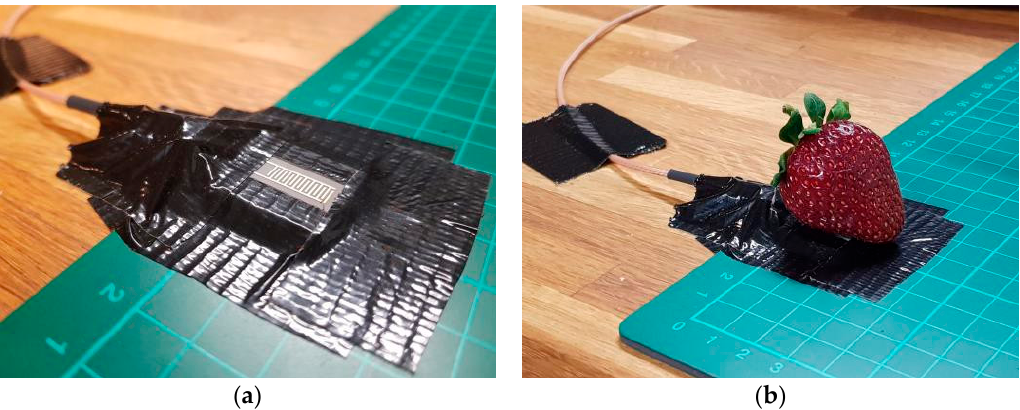
Figure 3. ( a ) 8-pair IDE sensor, with only sensitive element exposed and ( b ) example with fruit in place for